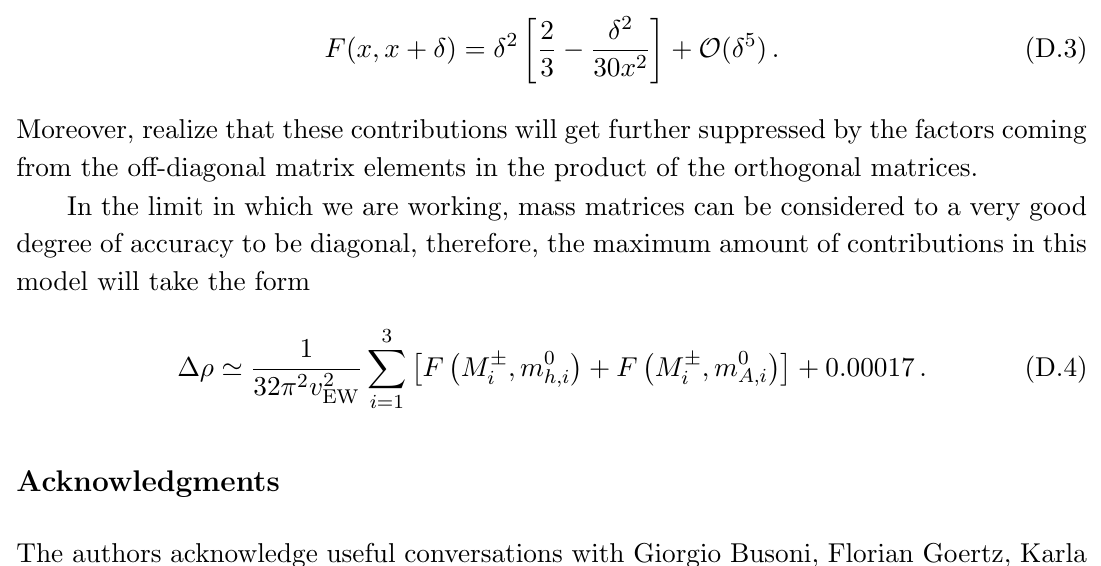
Figure 3 . Plot showing the di(cid:11)erent values for the function F ( x; x + (cid:14) ) = (32 (cid:25) 2 v 2 f 1 ; 10 ; 50 ; 100 ; 150 ; 200 g GeV corresponding, from bottom to top, to the dashed lines (orange, red, purple, blue, magenta, cyan). The three continuous lines (one gray and two black) correspond to (cid:1) (cid:26) = 0 : 0005 and its 3 (cid:27) upper bound depending on whether the oblique parameter U is (cid:12)xed to zero or not. The value is strongly dominated by the mass di(cid:11)erence, (cid:14) , whenever scalar masses are in the range M > 300